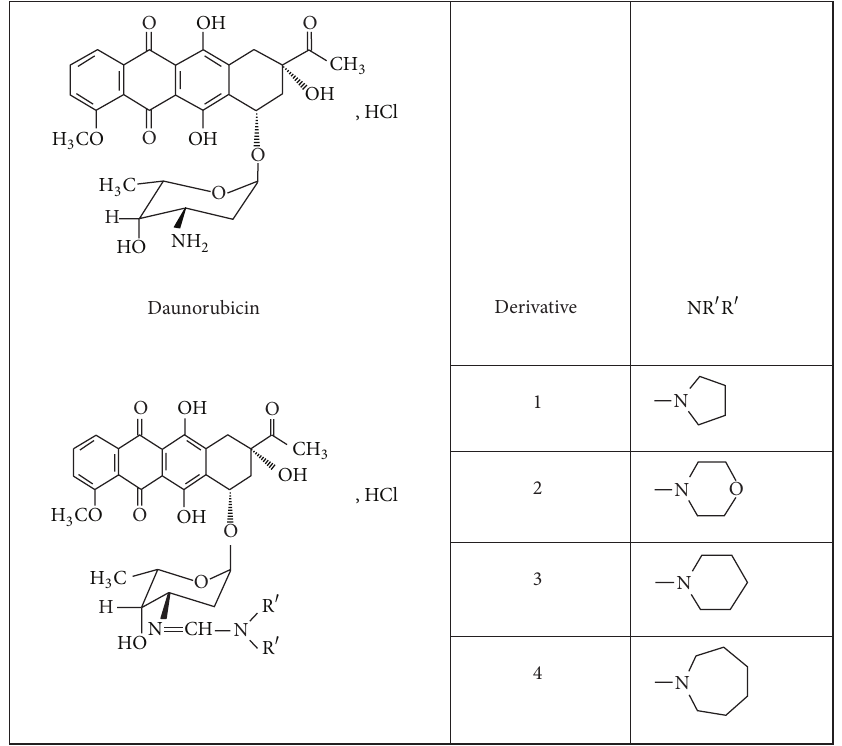
Figure 1: The chemical structure of daunorubicin and its four amidine derivatives.